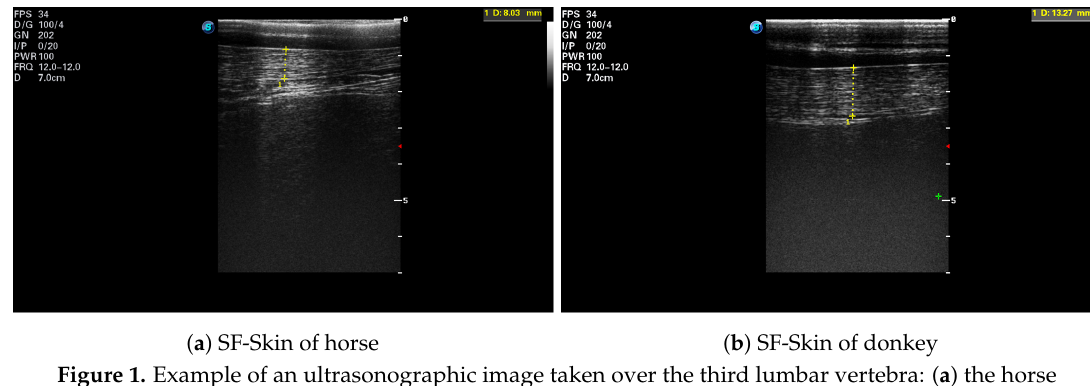
Figure 1. Example of an ultrasonographic image taken over the third lumbar vertebra: ( a ) the horse H.1 ; ( b ) the donkey D.3 . The subcutaneous fat plus skin thickness (SF-Skin) is